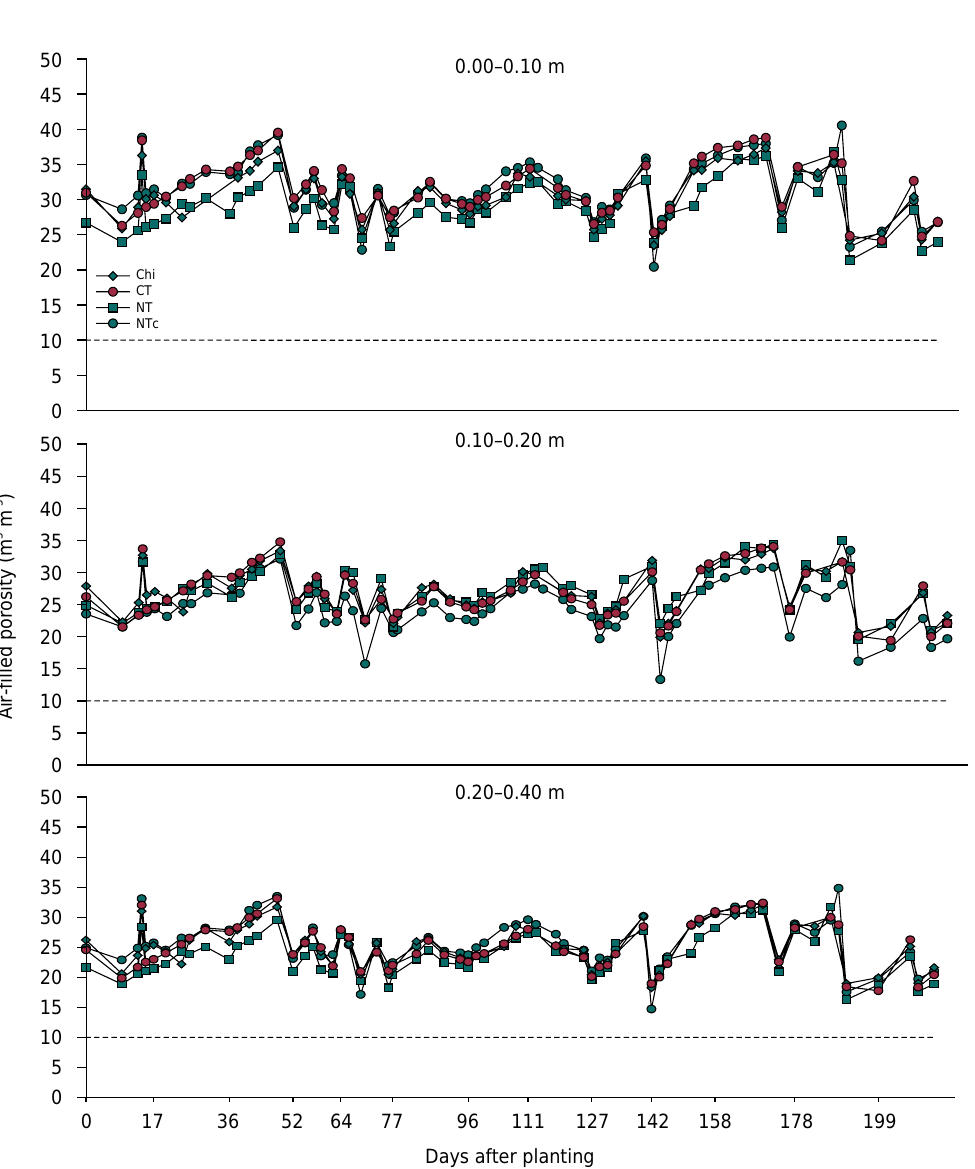
Figure 4. Air-filled pore space for chisel plow (Chi), conventional tillage (CT), no-tillage (NT), and compacted no-tillage (NT C ), in three soil layers, during cassava